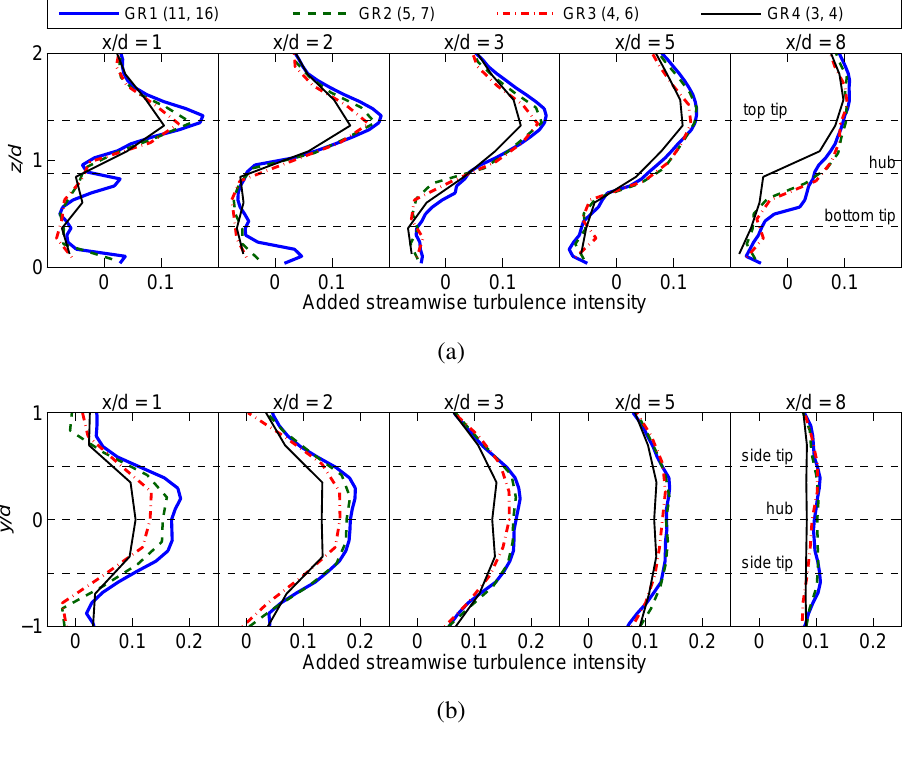
Figure 16. Comparison of vertical ( a ) and lateral ( b ) profiles of the added streamwise turbulence intensity I on the xz and xy planes, respectively, through the turbine u,add top-tip